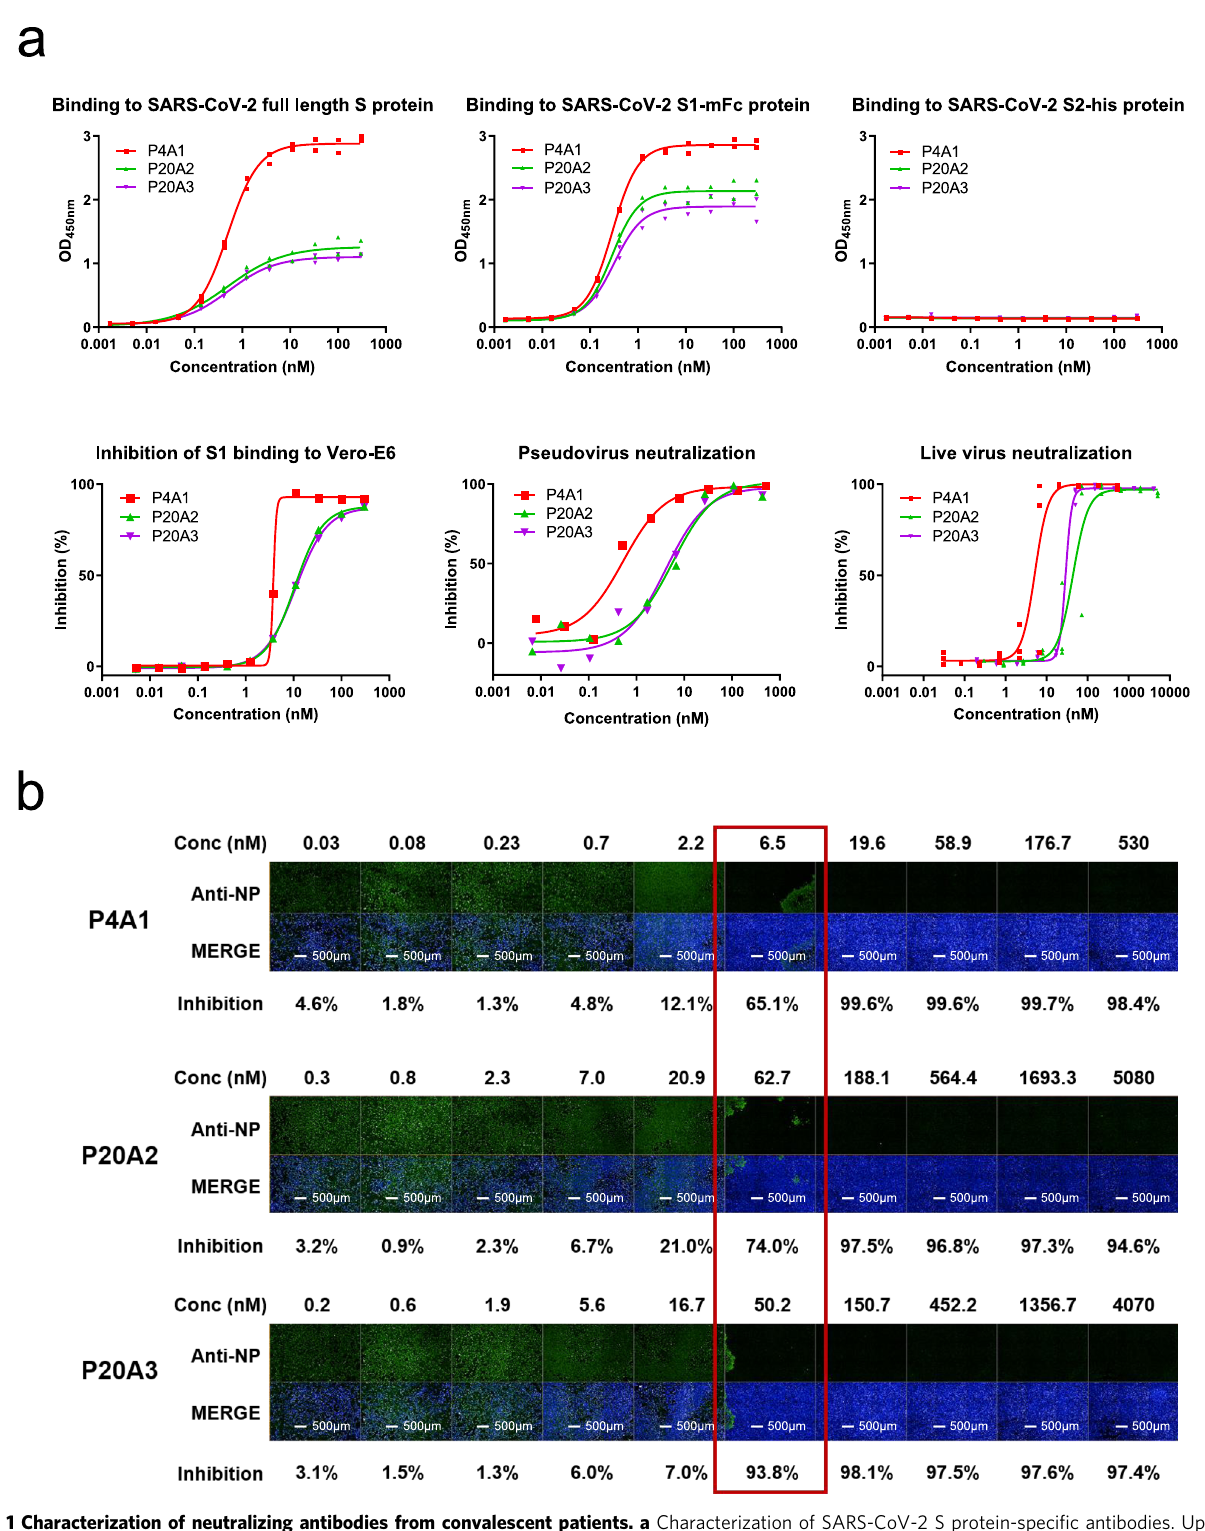
Fig. 1 Characterization of neutralizing antibodies from convalescent patients. a Characterization of SARS-CoV-2 S protein-speci fi c antibodies. Upper panels: binding of antibodies to the full-length S protein, S1 protein, and S2 protein was evaluated by ELISA (in duplicates with symbols show each of the replicates). Lower left panel: blockage of the binding of SARS-CoV-2 Spike S1 protein to Vero E6 cells by antibodies evaluated by fl ow cytometry (data in singleton). Lower middle panel: pseudovirus neutralization assay in Huh-7 cells (data in singleton). Lower right panel: in triplicates with symbols show each of the triplicates and SARS-CoV-2 live virus neutralization assay. All experiments were repeated at least two more times (except S2 binding that was repeated one more time) with similar results. b Images of Vero E6 cell-infected SARS-CoV-2 treated with antibodies of different concentrations. Green (stained with SARS-CoV-2 nucleocapsid protein (NP) antibody) indicates viral infected cells and blue (Hoechst 33258) represents cell nuclei. Experiment was performed in triplicates and repeated two more times with similar